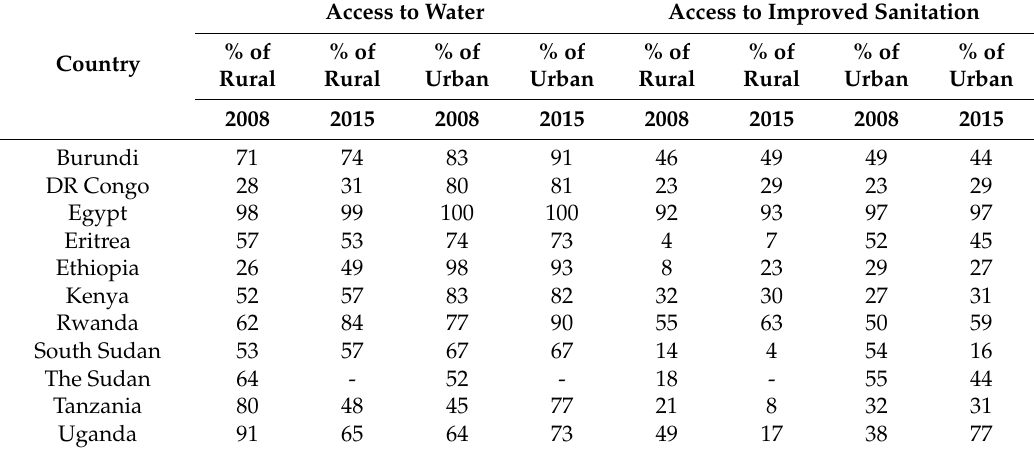
Table 4. Nile Basin access to potable water and improved sanitation (percentage of rural and urban populations). Source: NBI (2016) for the 2015 access to potable water and improved sanitation data ([24], p. 61). An estimate of the rural population with access to improved sanitation and